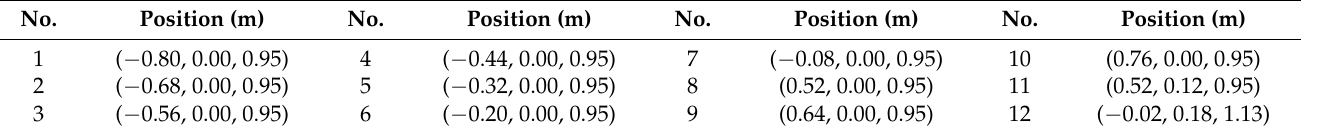
Figure 4. Waveforms of transmitting signals from 12 Vavaldi antennas on Chang’E-5. Table 1. The specific positions of Chang’E-5 Antennas. Table 1. The specific positions of Chang’E-5 Antennas.